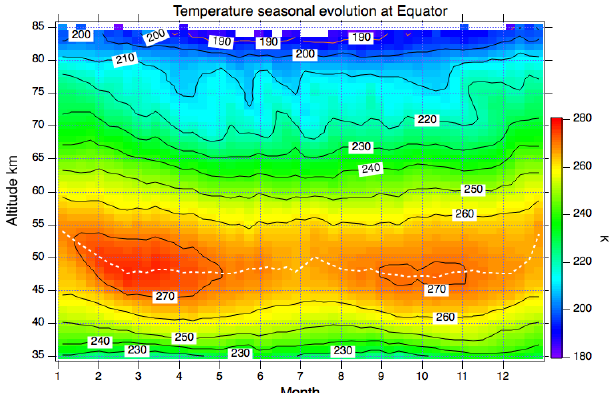
Figure 10. Seasonal evolution of the equatorial temperature de- rived from temperature data presented in Fig. 2 The altitude of the stratopause is indicated by the white dotted